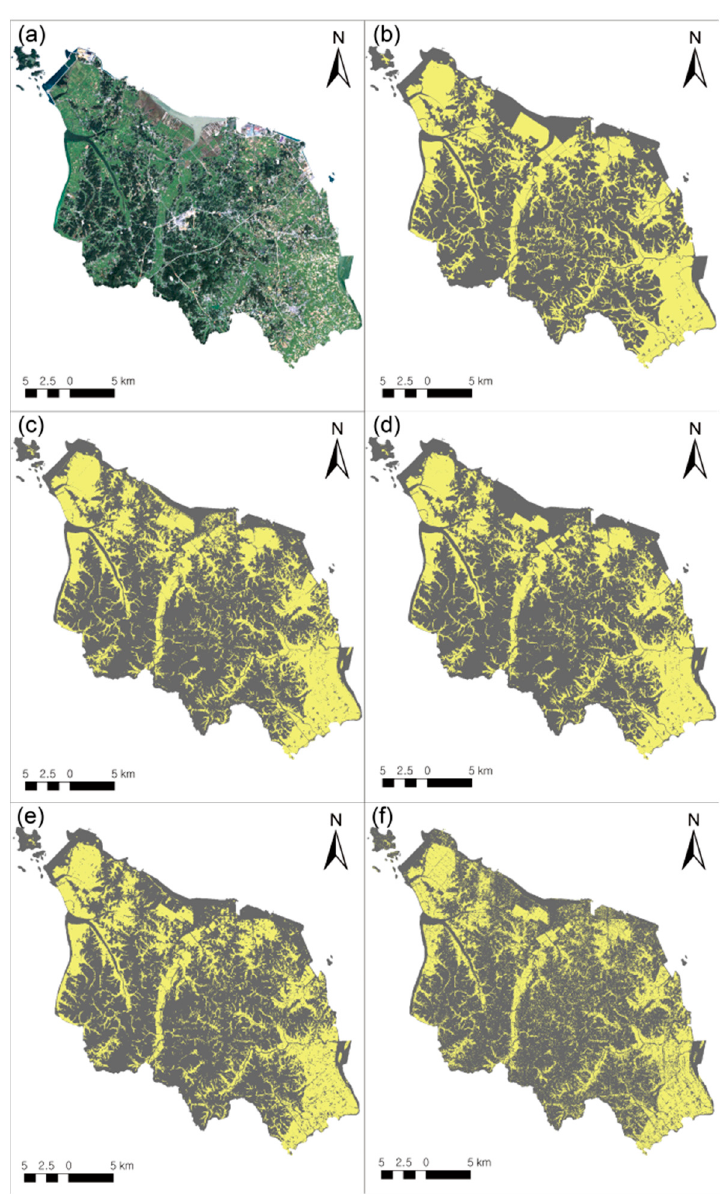
Figure 8. Spatial distribution of paddy rice maps at site B. ( a ) Landsat 5 RGB image on 21 September 2003; ( b ) reference map; ( c ) Random forest (scheme 6)-derived map; ( d ) SVM (scheme 6)-derived map; ( e ) PMI (NIR)-derived map; and, ( f ) PMI (SAR)-derived map. Paddy rice fields are shown in yellow.